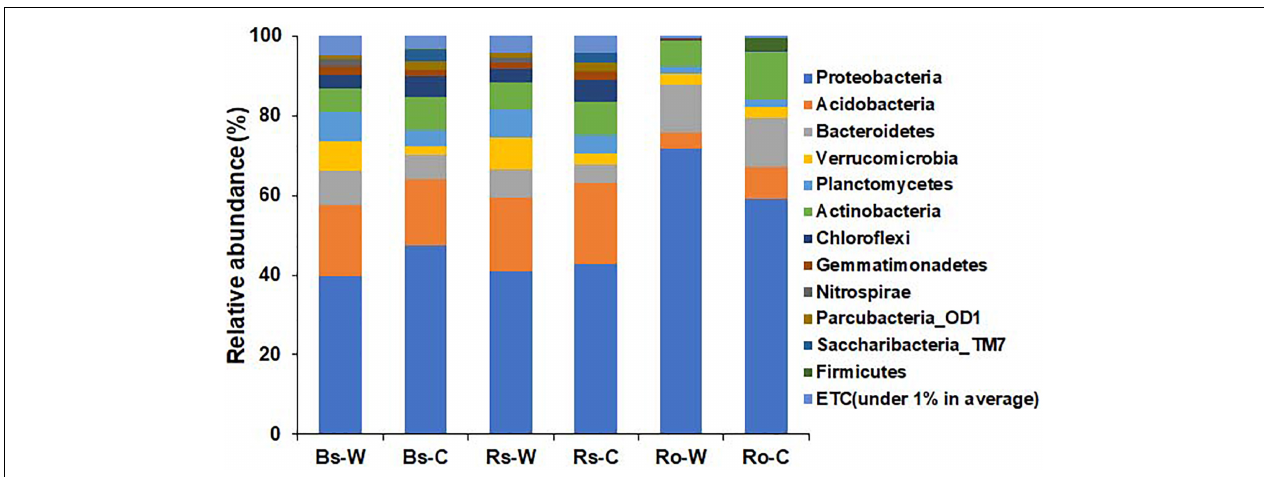
FIGURE 3 | Comparison of bacterial composition and relative abundance at the phylum level in bulk soil (Bs), rhizosphere soil (Rs), and root (Ro) of long-sepal Donggang pasque-flower plant collected from wild (-W) and cultivated (-C) areas. A phylum with relative abundance less than 1% was referred to as